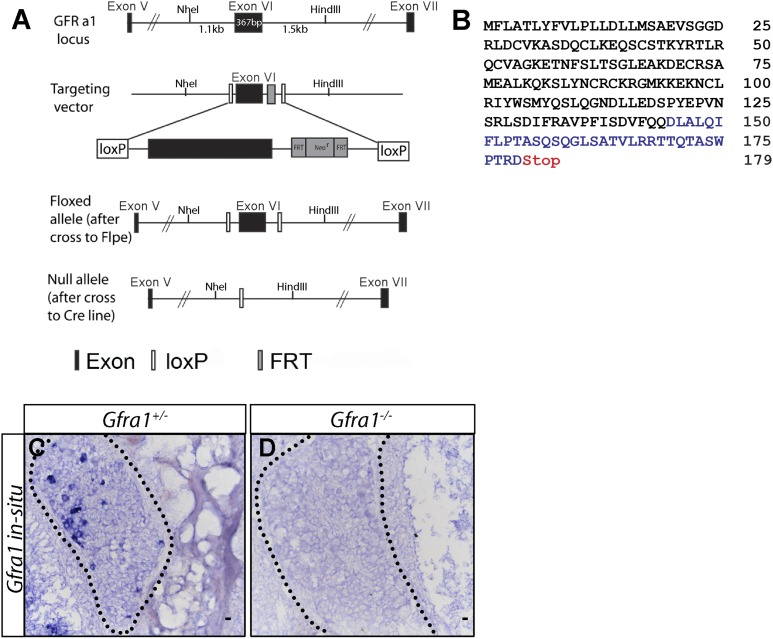
Generation of Gfra1 conditional and null alleles.(A) Schematic of generation of Gfra1 conditional and null alleles. See supplemental ‘Materials and methods’ for additional details. (B) Predicted peptide sequence of the truncated GFRa1 protein after the excision of exon 6. Black letters represent amino acids which share identity with wild-type protein sequence. The loss of exon 6 causes a frame shift, leading to the inclusion of amino acids which do not match the wild-type sequence (blue letters). The frame shift also introduces a premature stop codon following amino acid 179. (C–D) In situ hybridization of Gfra1 in P0 Gfra1+/+ control (C) and Gfra1−/− null (D) DRG sections shows a complete loss of Gfra1 transcript in Gfra1 null tissue.